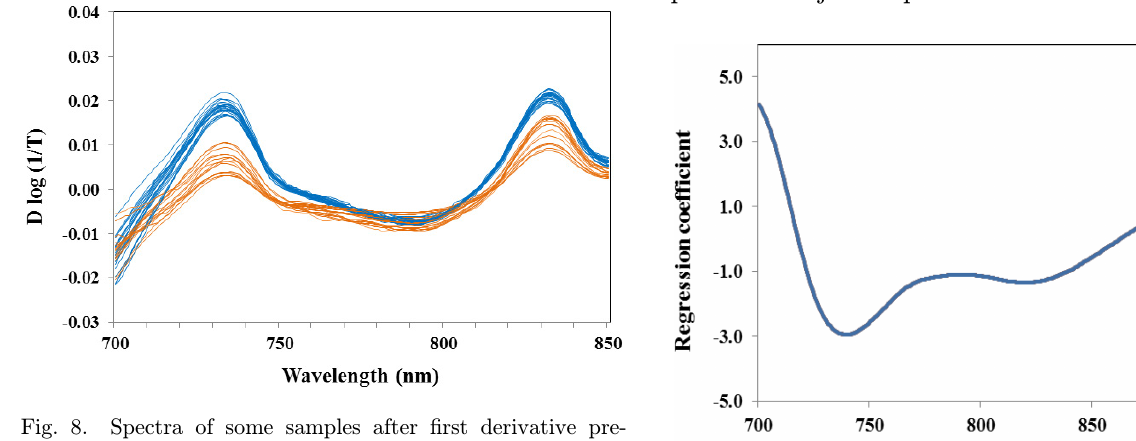
Fig. 8. Spectra of some samples after ¯rst derivative pre- treatment measured in the wavelength 700 – 850 nm. Black lines indicated accepted normal pears, and gray lines represented rejected watercore pears.